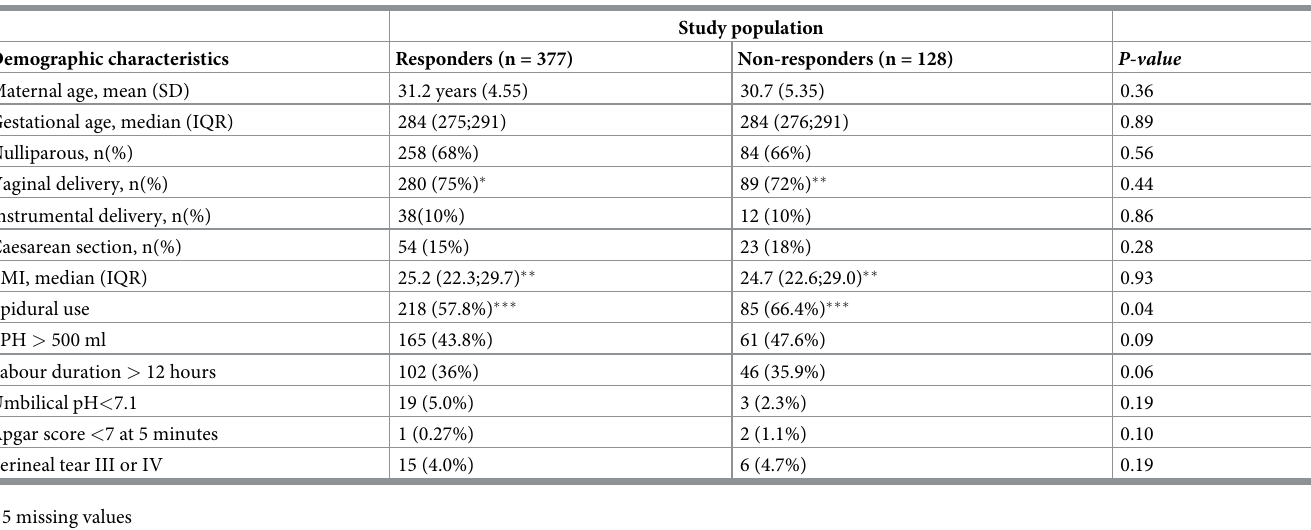
Table 2. Baseline characteristics of the study